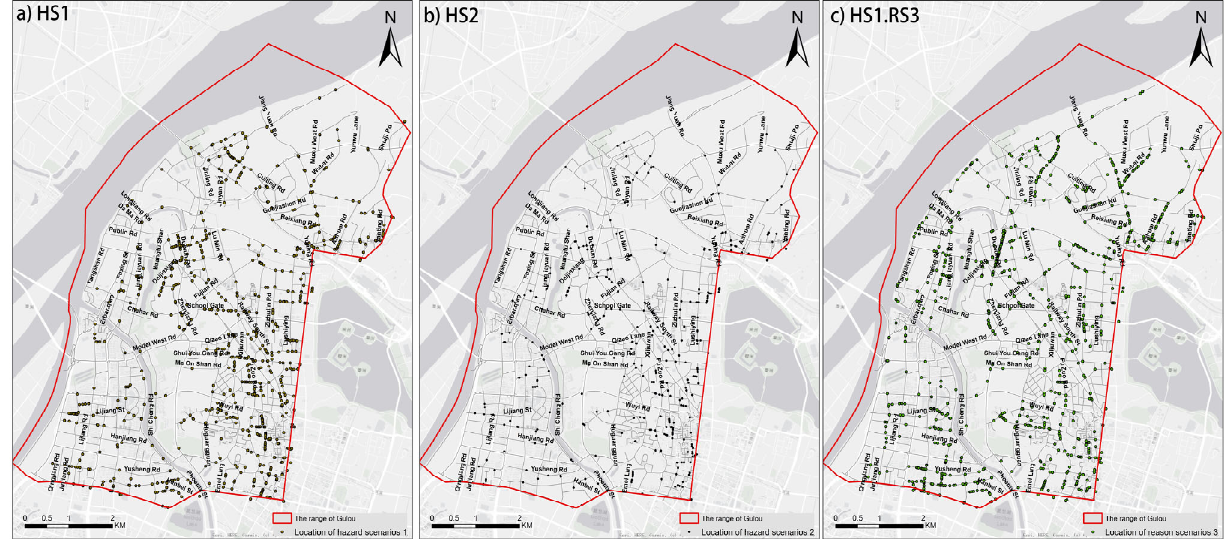
Figure 14. The distribution of various types of scenarios.